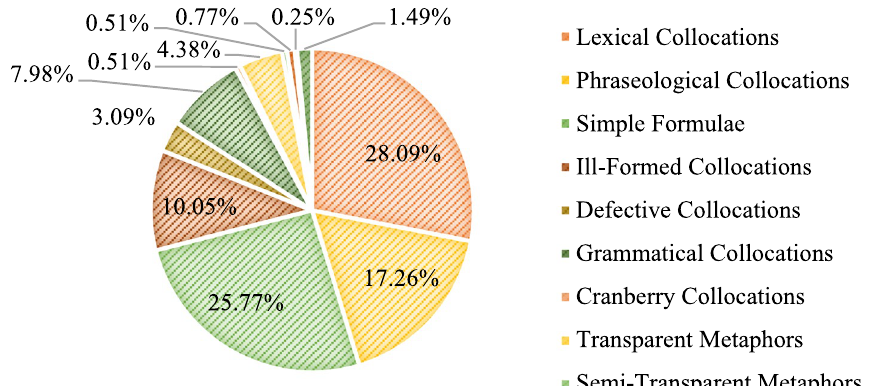
Fig. 7 Percentages of each phraseological unit type used in band scores